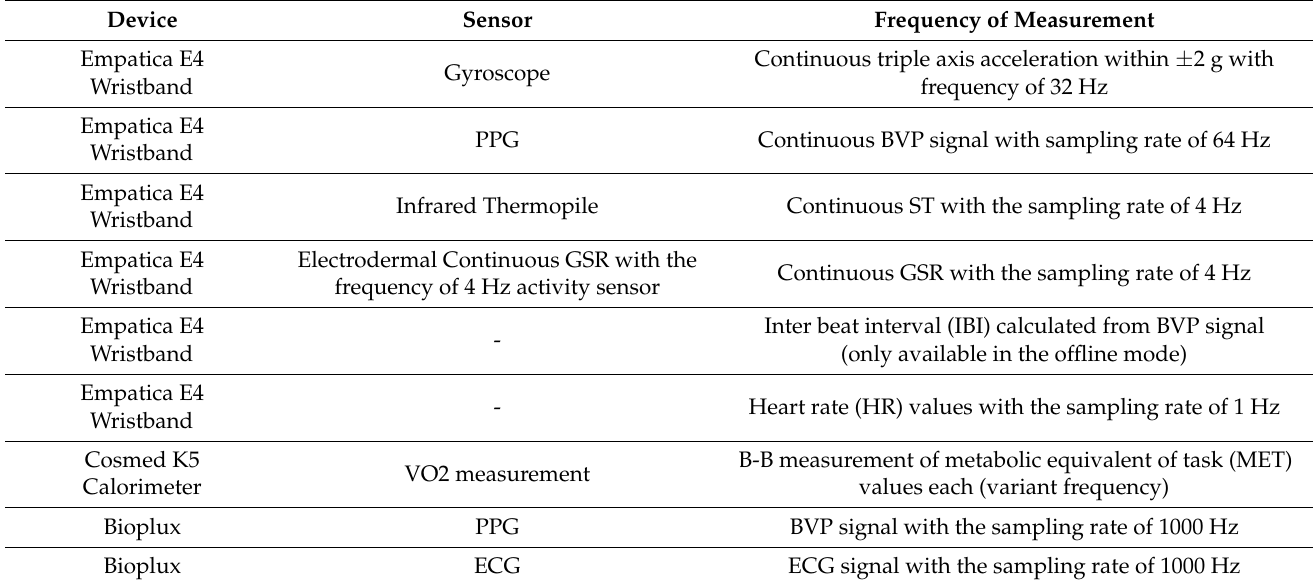
Table 1. The characteristics of measurement devices Empatica E4, Cosmed K5, Bioplux.